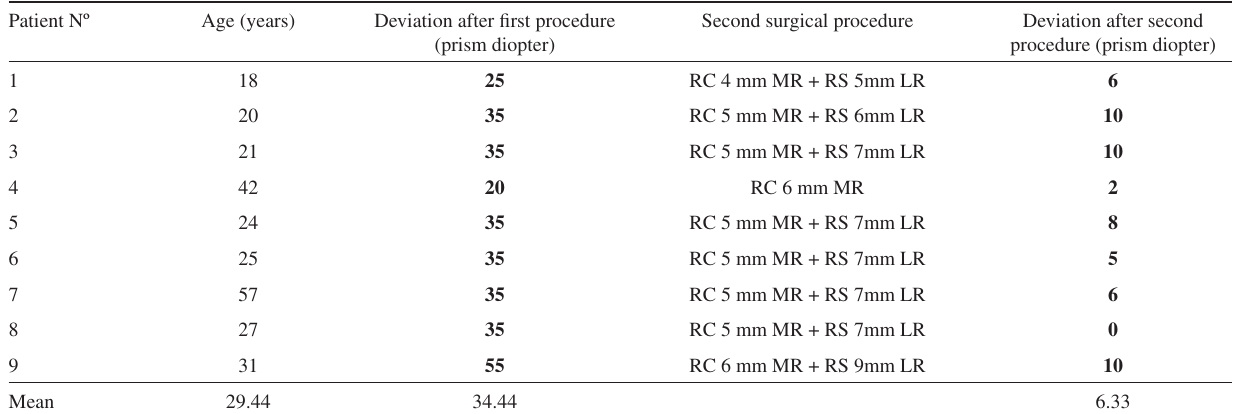
Table 3 - Group 1 patients (esotropia) who underwent a second procedure Patient Nº Age (years) Deviation after first procedure Second surgical procedure Deviation after second (prism diopter) procedure (prism